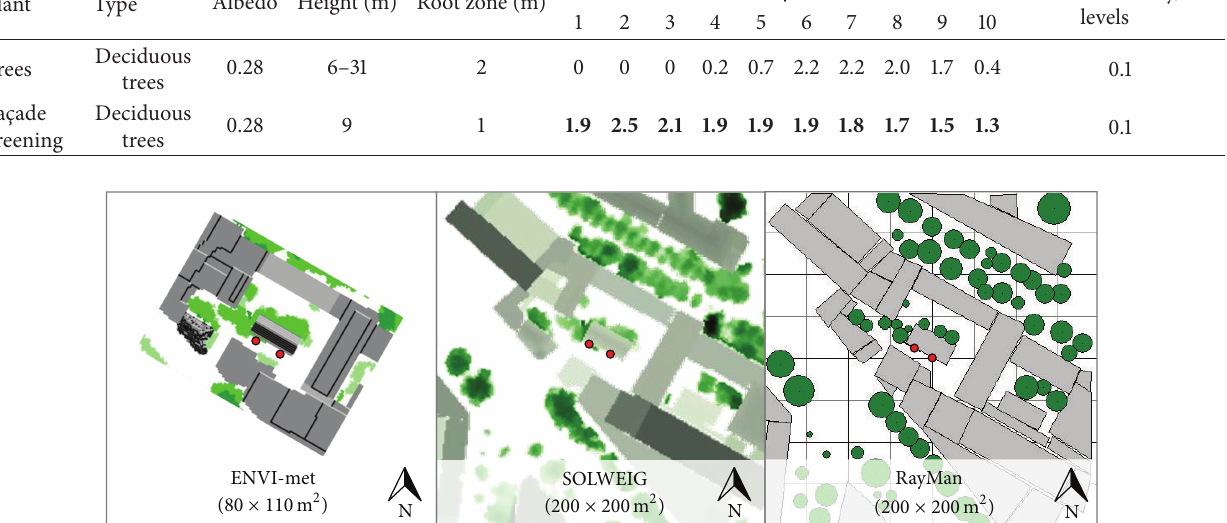
Leaf area density (LAD) at level